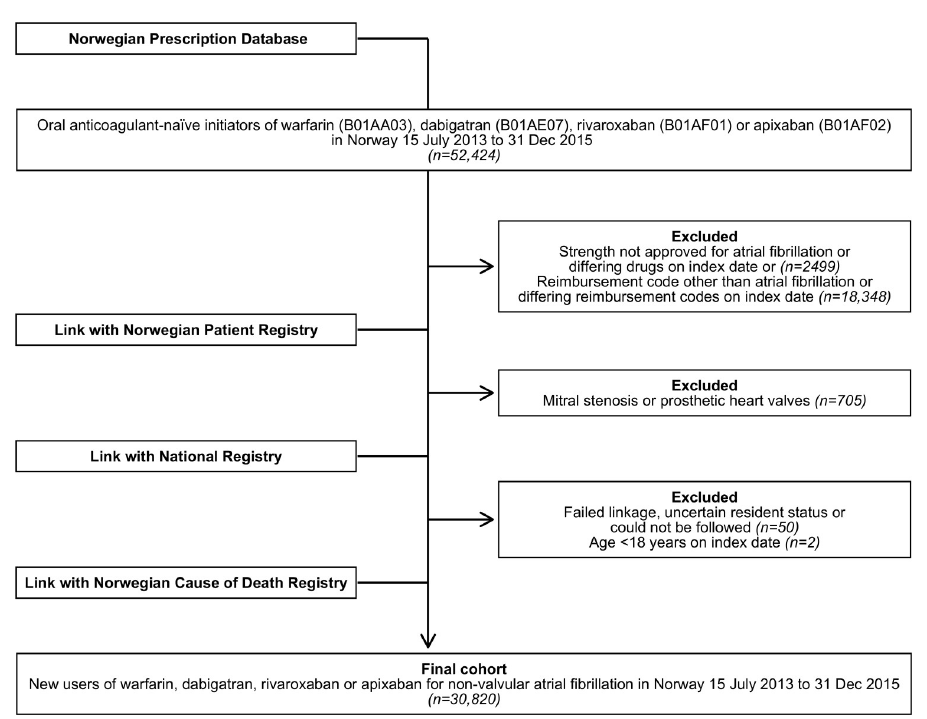
Fig 1. Study population selection. Flowchart showing selection of the final study population of new users of warfarin, dabigatran, rivaroxaban or apixaban for non-valvular atrial fibrillation from 15 July 2013 to 31 December 2015 in Norway by linkage of nationwide